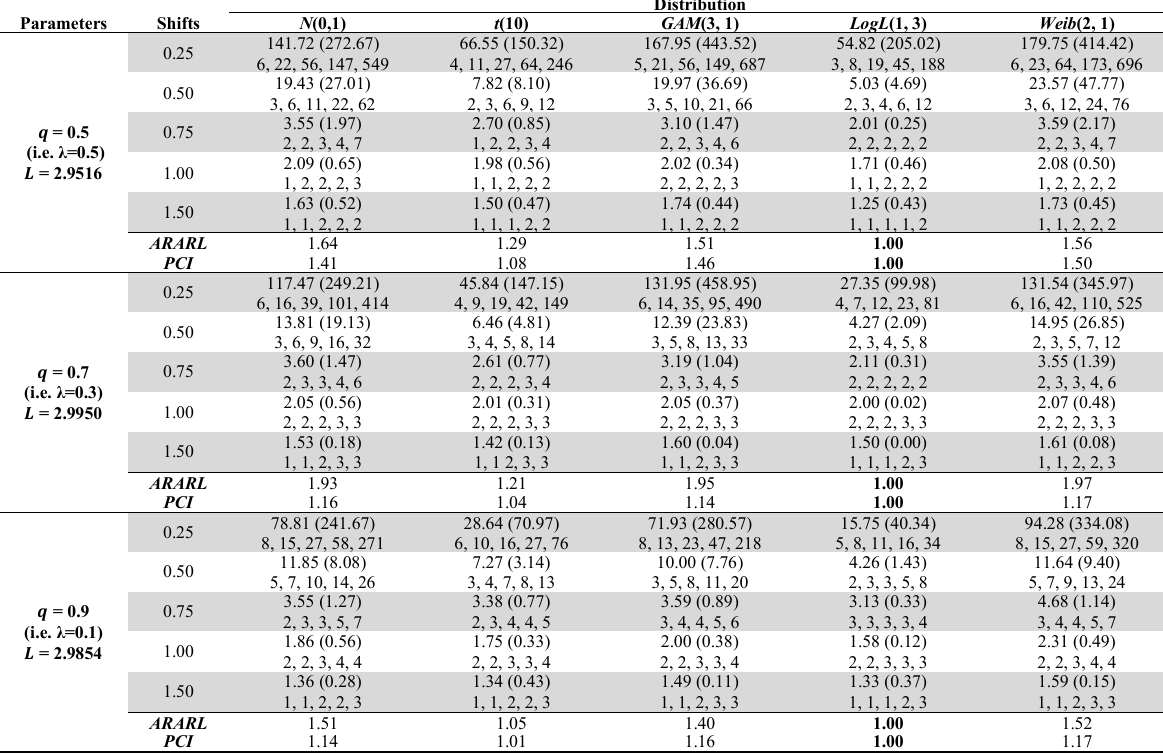
Case A OOC characteristics of the run-length distribution and overall performance of the W-GWMA( 𝑞, 𝛼 ) (or W-EWMA(λ)) scheme when 𝛼 = 1, ( m , n ) = (100, 5), 𝑞 = 0.5, 0.7 & 0.9 and 𝛿 nominal 𝐴𝑅𝐿 value of 500 (cid:2868)